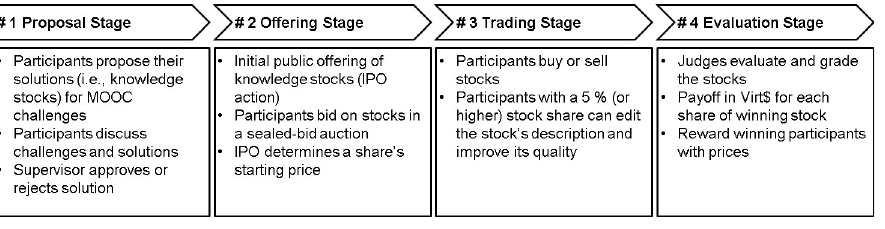
Fig 2. Sequence of actions in a KSX